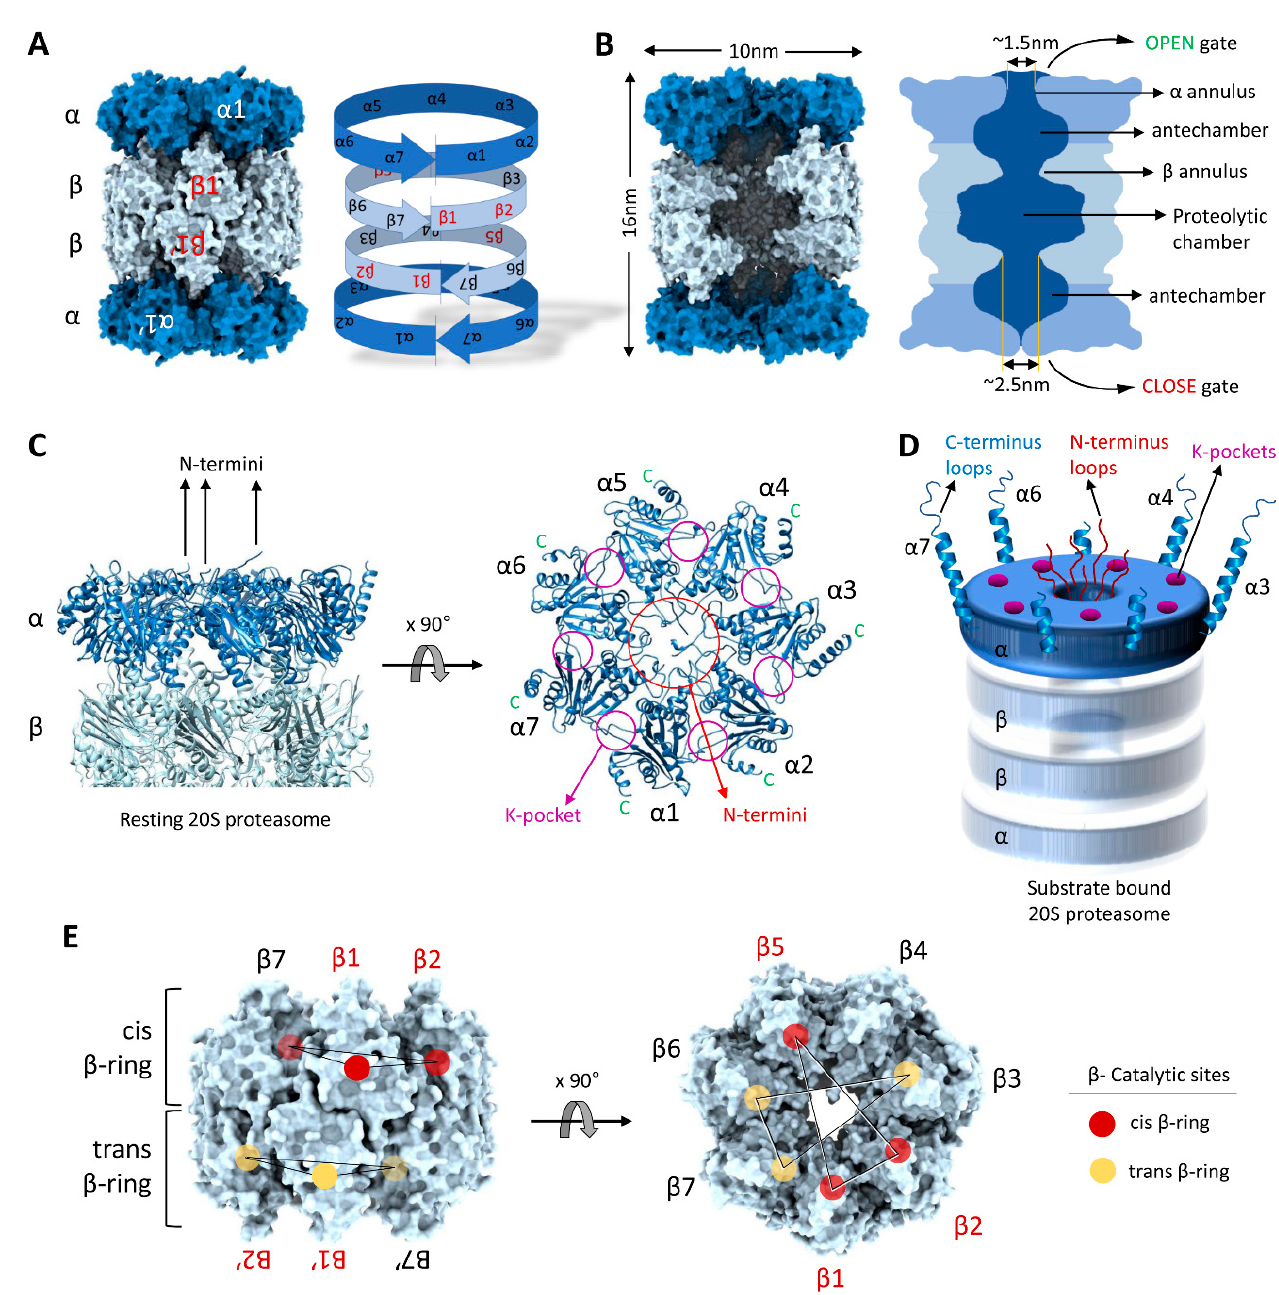
Figure 3. Structural precision of 20S proteasomes for substrate degradation. ( A ) The C2-symmetry of the 20S proteasome complex highlighting α -rings and the β -rings. ( B ) A slice through the interior of the 20S proteasome highlighting the proteolytic chamber separated from the two antechambers by β -annulus. ( C ) Central location of α -subunit N-termini and the peripheral positions of α -subunit C-termini in resting 20S proteasomes. ( D ) A cartoon representation of the N-termini, C-termini and K-pockets on the α -ring of substrate-engaged 20S proteasomes. ( E ) Spatial distribution of the β -subunit catalytic sites ( β 1, β 2 and β 5) in cis- and trans- β -rings. The model figures of 20S complexes were generated by ChimeraX using the 20S cryo-EM structure [49] .